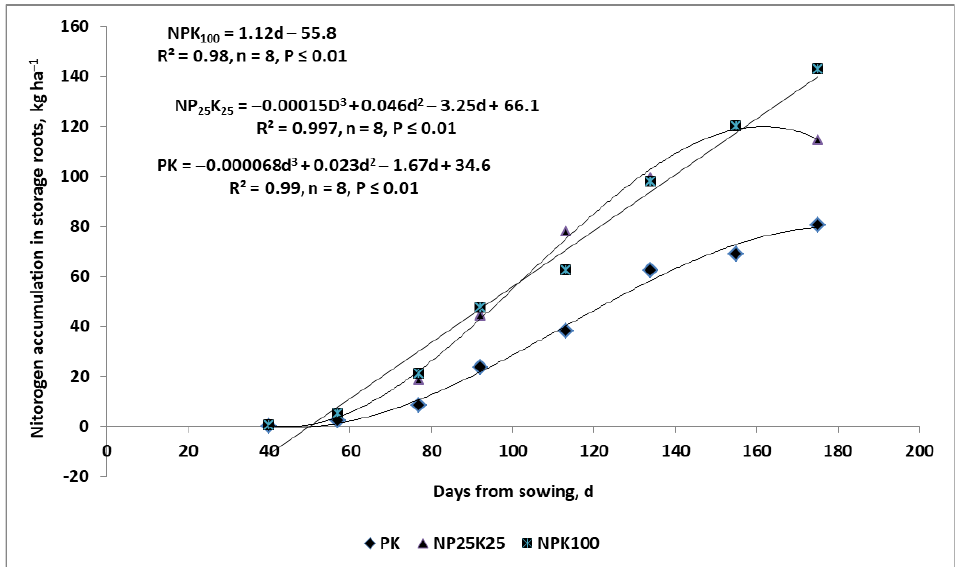
Figure 7. Effect of NPK fertilization systems on nitrogen accumulation in storage roots of sugar beets (based on Szczepaniak et al. [125]). Legend: PK — NPK100 — the applied amount of P and K; N control; NP25K25 — P and K applied at a dose of 25% compared to NPK100.